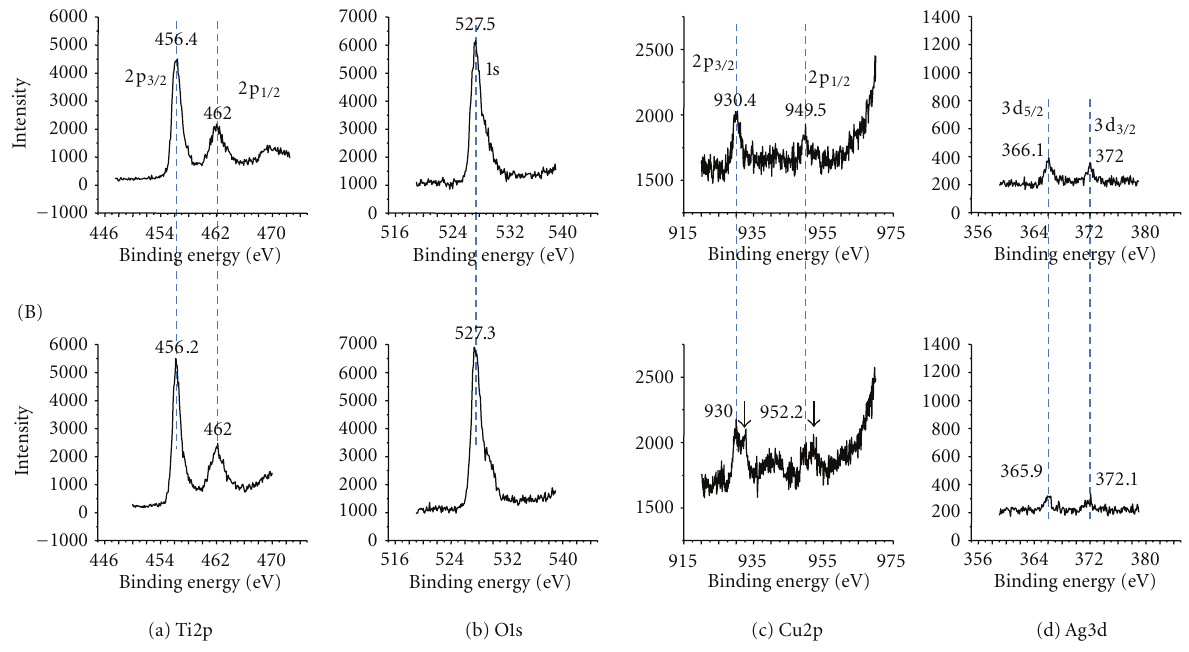
Figure 8: The XPS for Cu2p, Ag3d, Ti2p, and O1s of Cu(0.03)-Ag(0.07)Ti(0.9)O 2 before and after the methanol/water photodecomposition reaction: (A) before reaction and (B) after